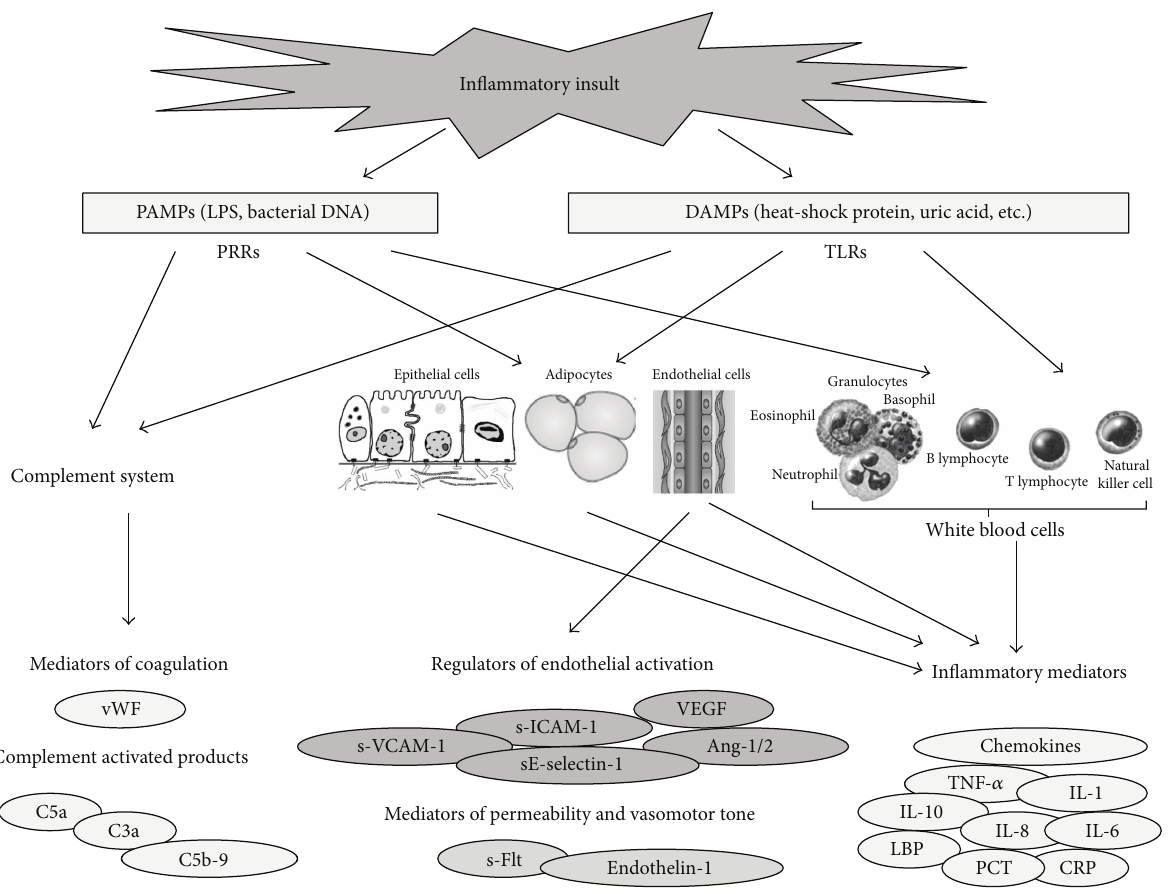
Figure 1: Schematic of events associated with major mediators of cytokine cascade on initiation of sepsis. The release of a large amount of pathogen and damage associated molecular patterns (PAMPs and DAMPs) from invading microorganisms and/or damaged host tissue, respectively, results in the overstimulation of pattern-recognition receptors (PRRs) of immune cells. This process activates an inflammatory cascade in which large amounts of cytokines are released into the body. Macrophages and endothelial cells are then hyperactivated by the unusually large quantity of circulating cytokines. The activation of macrophages and endothelial cells results in the release of more cytokines, exacerbating the inflammatory response. The profound proinflammatory response is counteracted by certain anti-inflammatory cytokines, including IL-10, transforming growth factor- 𝛽 (TGF- 𝛽 ), and IL-4, which attempt to restore immunological